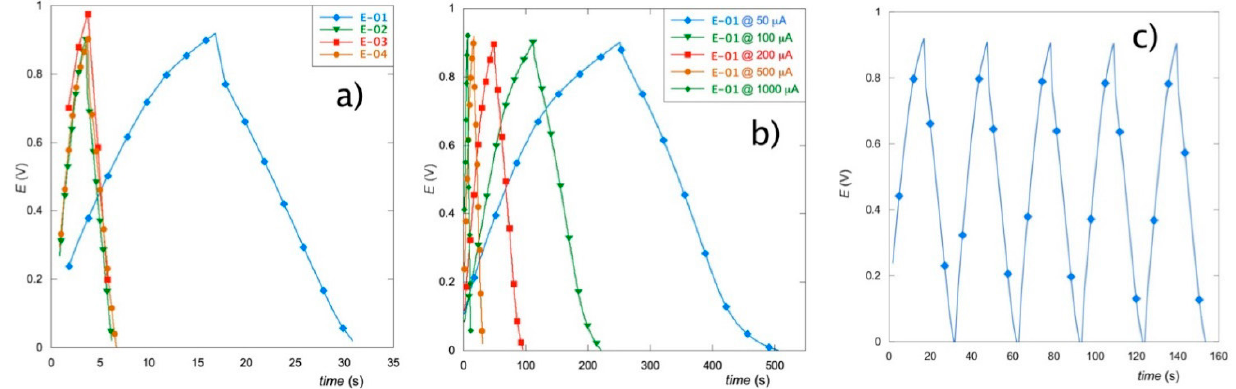
Figure 7. Galvanostatic charge–discharge curves of all the prepared electrodes at 500 µ A cm − 2 ( a ); of E-01 sample in the 50–1000 µ A cm − 2 current density range ( b ); Cycle stability of E-01 sample at 500 µ A cm − 2 ( c ). Potential range: 0.0–0.9 V. Electrolyte: Na 2 SO 4 0.1 mol L − 1